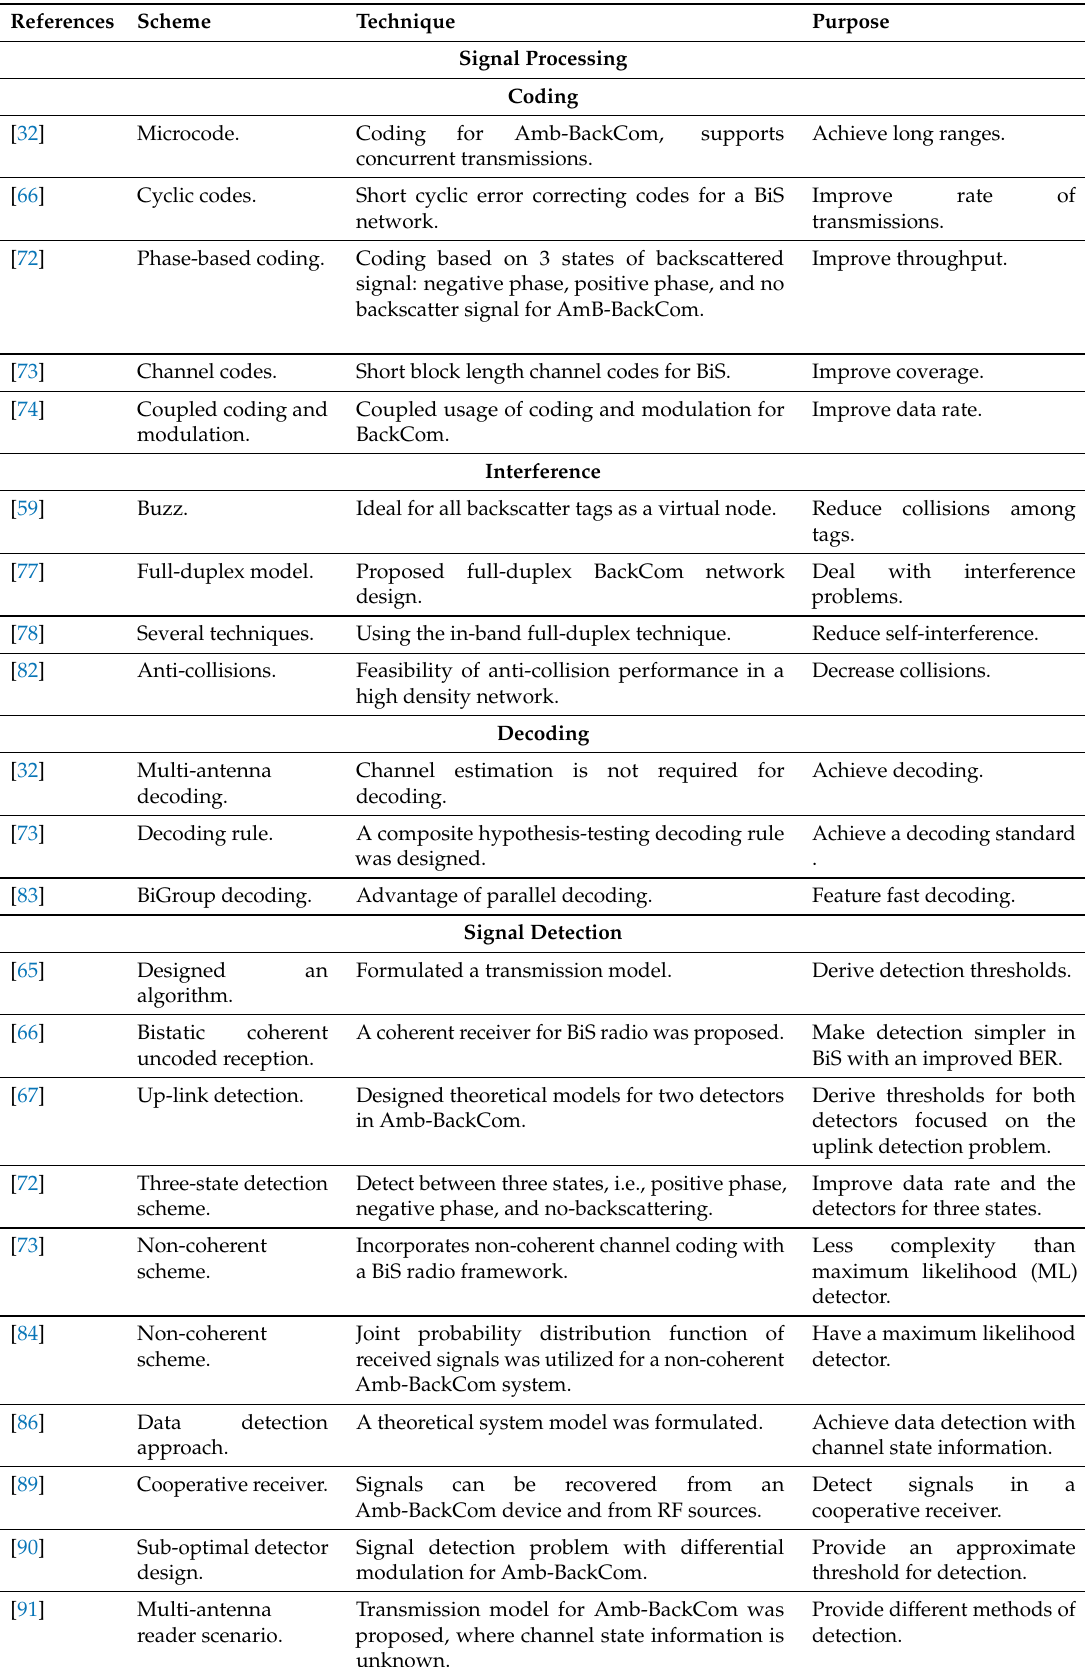
Table 4. Summary of signal processing and signal